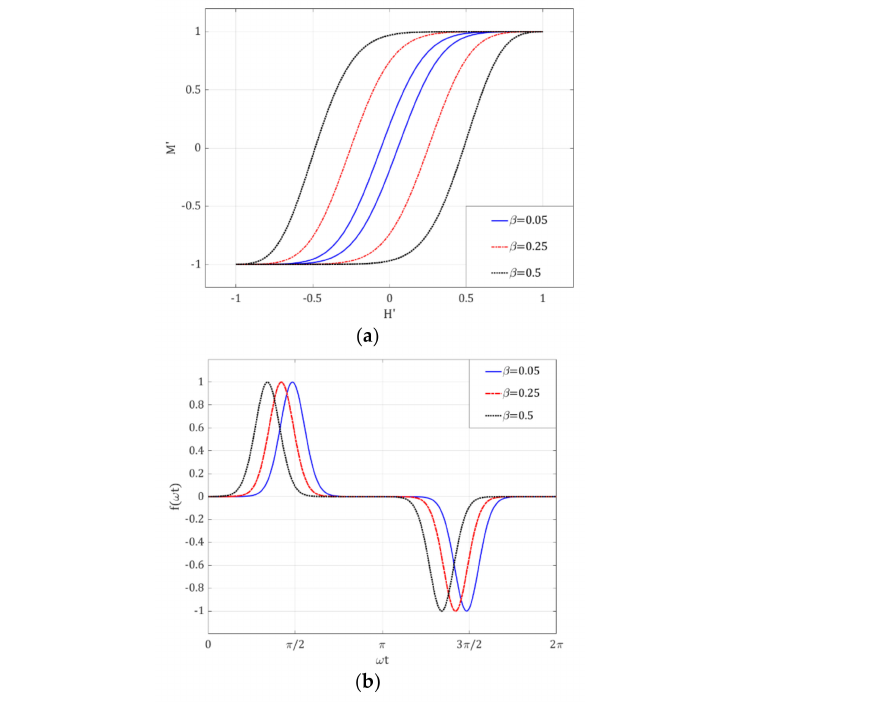
Figure 4. Effect of β on normalized hysteresis loops ( a ) and corresponding functions ( b ).